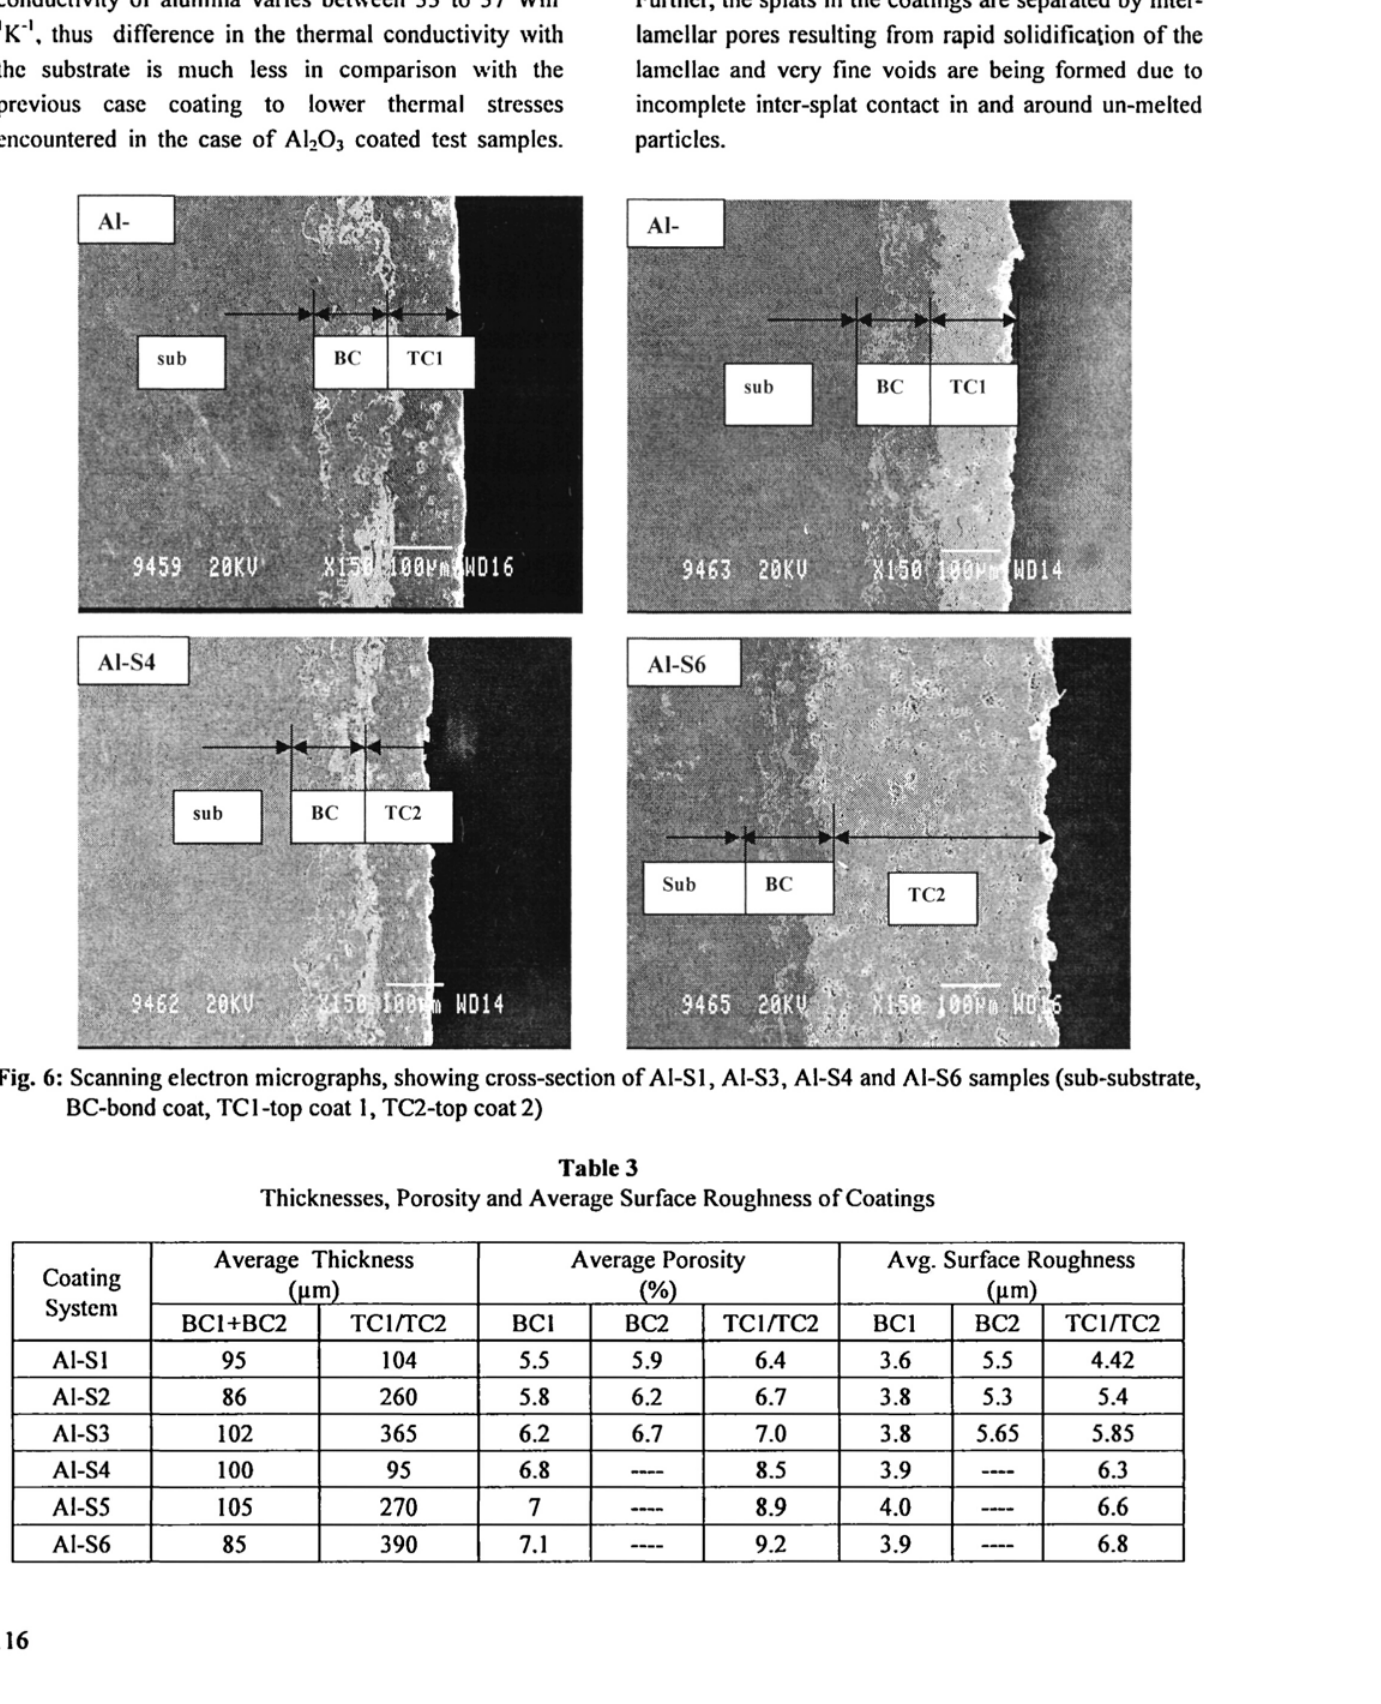
Fig. 6: Scanning electron micrographs, showing cross-section of ΑΙ-SI, A1-S3, A1-S4 and AI-S6 samples (sub-substrate, BC-bond coat, TCI-top coat 1, TC2-top coat 2)